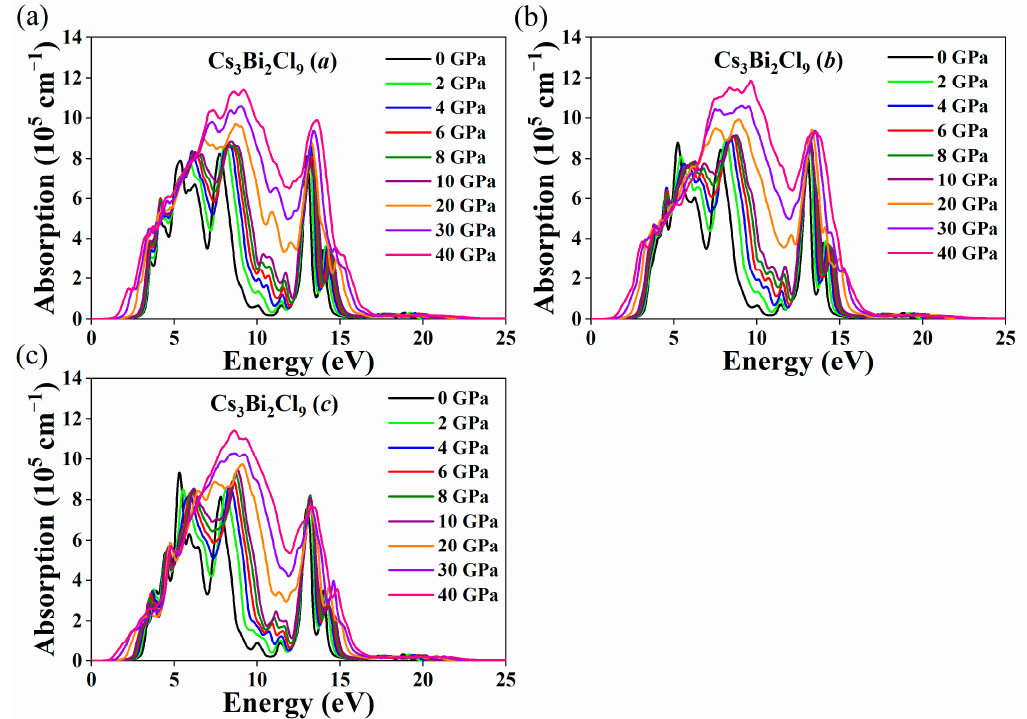
Figure 10. Absorption coefficients of Cs 3 Bi 2 Cl 9 along the a -axis ( a ), along the b -axis ( b ), and along the c -axis ( c ) as a function of the pressure (from 0 to 40